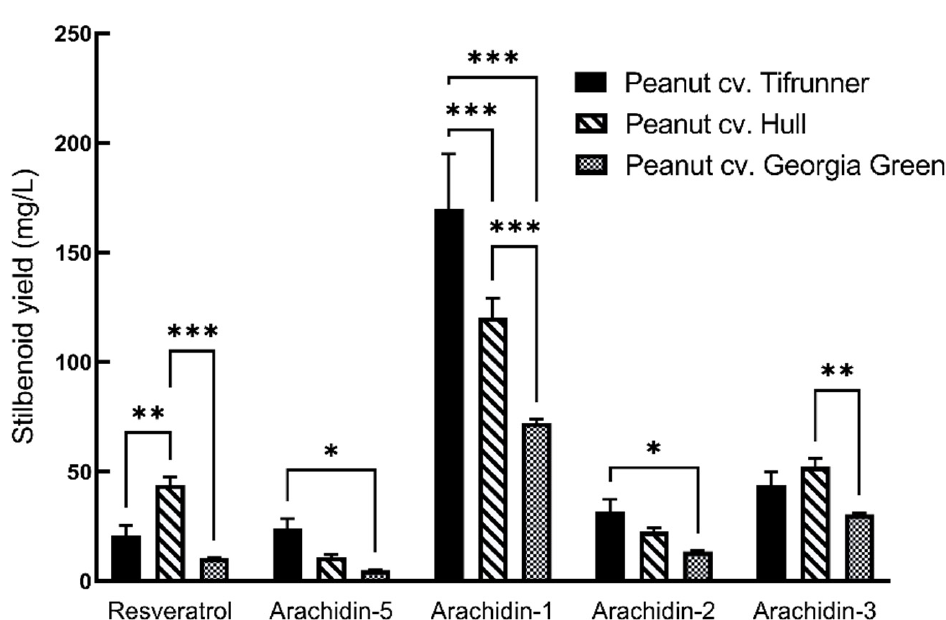
Figure 5. Comparison of stilbenoid yield in hairy root cultures of peanut cultivars Tifrunner, Hull (line 3), and Georgia Green. Yield is expressed in mg/L and each bar represents the average of three technical replicates of stilbenoids extracted from 0.9 L elicited medium. Error bars represent standard deviation. Statistical analysis was performed with two-way ANOVA with Tukey’s multiple-comparisons test. The asterisks above the connecting line represent a significant difference when compared to the stilbenoid yield among the three cultivars (*, p < 0.033; **, p < 0.002; ***, p < 0.001). Particularly in the Tifrunner cultivar, arachidin-1 and arachidin-6 were the predomi- nant stilbenoids when compared to the Georgia Green and Hull cultivars. We identified arachidin-6 in the ethyl acetate extract of the culture medium by comparing characteristic UV spectrum ( λ max ), and mass spectrometric analysis of arachidin-6 from Rhizopus -elicited peanut seedlings [21] (Supplementary Materials Figures S3–S5). A total of 5.3 mg of arachidin-6 ( λ max = 344 nm), was purified from the peanut cv. Tifrunner hairy root